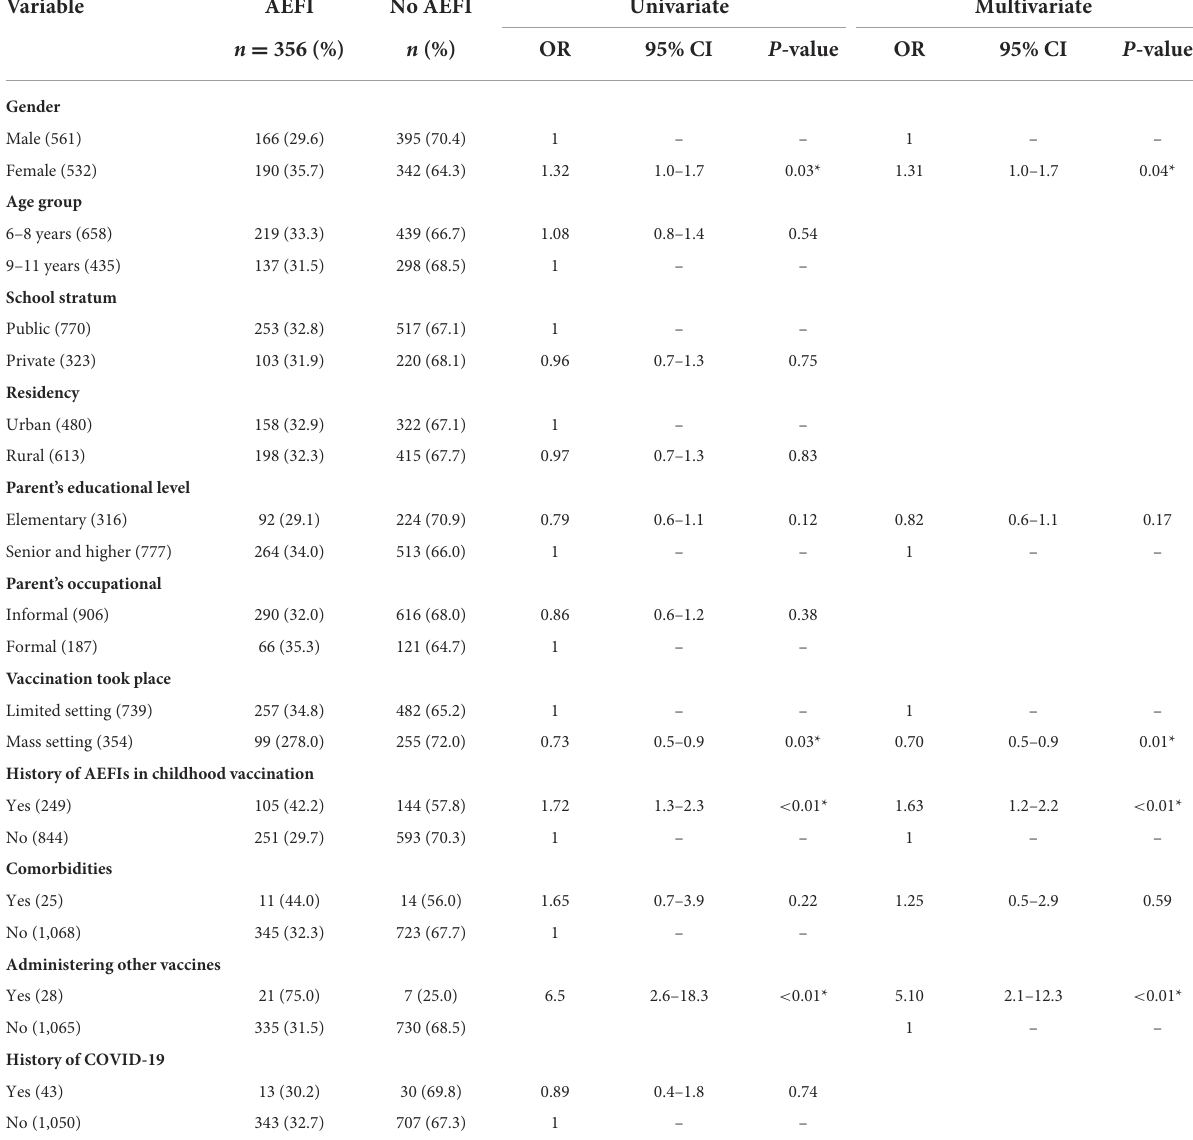
TABLE 3 Determinants of adverse events following of CoronaVac vaccine for children aged 6–11 years.